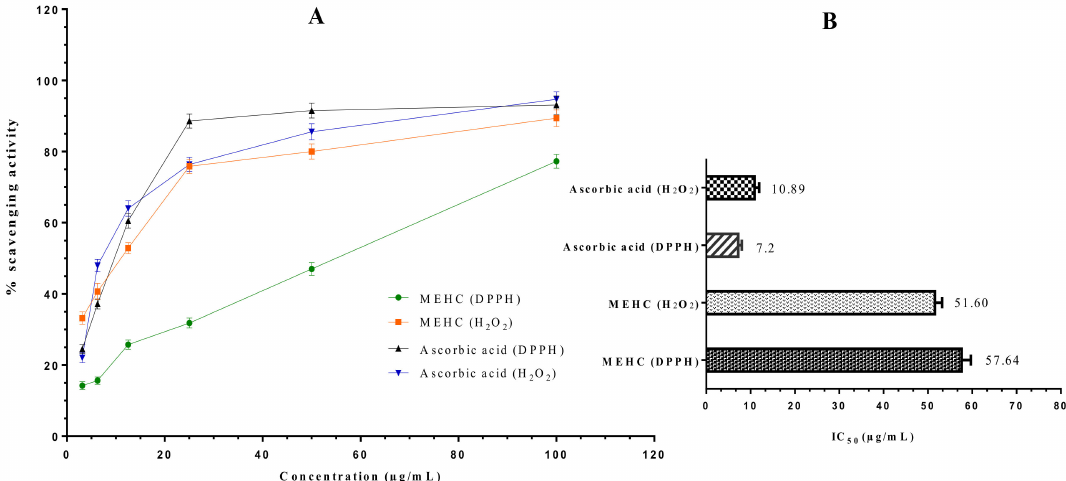
Figure 5. DPPH and H 2 O 2 free radical scavenging activity of MEHC compared with the reference standard ascorbic acid. ( A ) Percentage of DPPH and H 2 O 2 free radical scavenging activity by di ff erent concentrations of the MEHC and reference standard Ascorbic acid. Values are expressed as mean ± SD ( n = 3). ( B ) IC 50 values for DPPH and H 2 O 2 free radical scavenging activity of MEHC and Ascorbic acid. MEHC refers to methanol extract of Holigarna caustica leaves. DPPH: